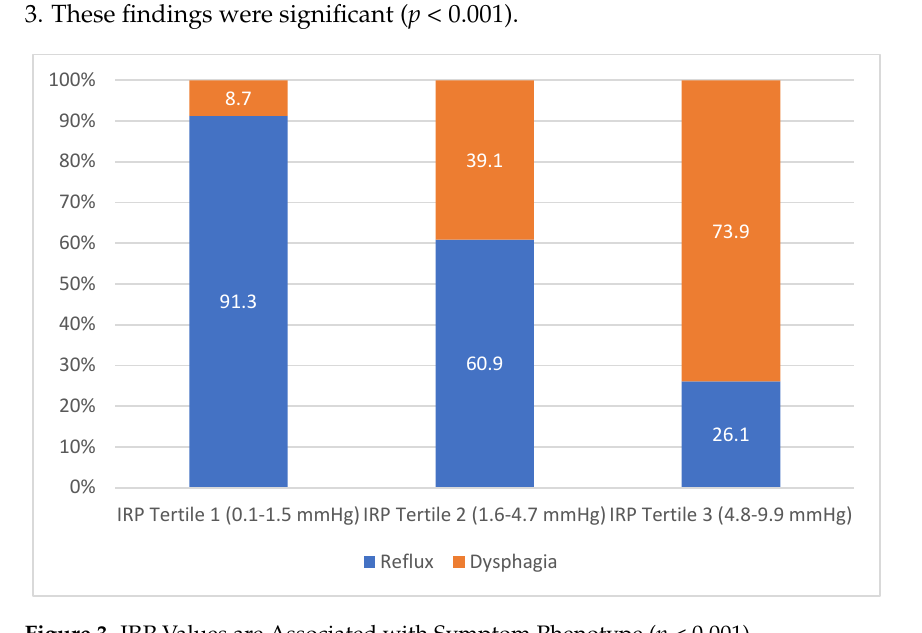
Figure 3. IRP Values are Associated with Symptom Phenotype ( p < 0.001).